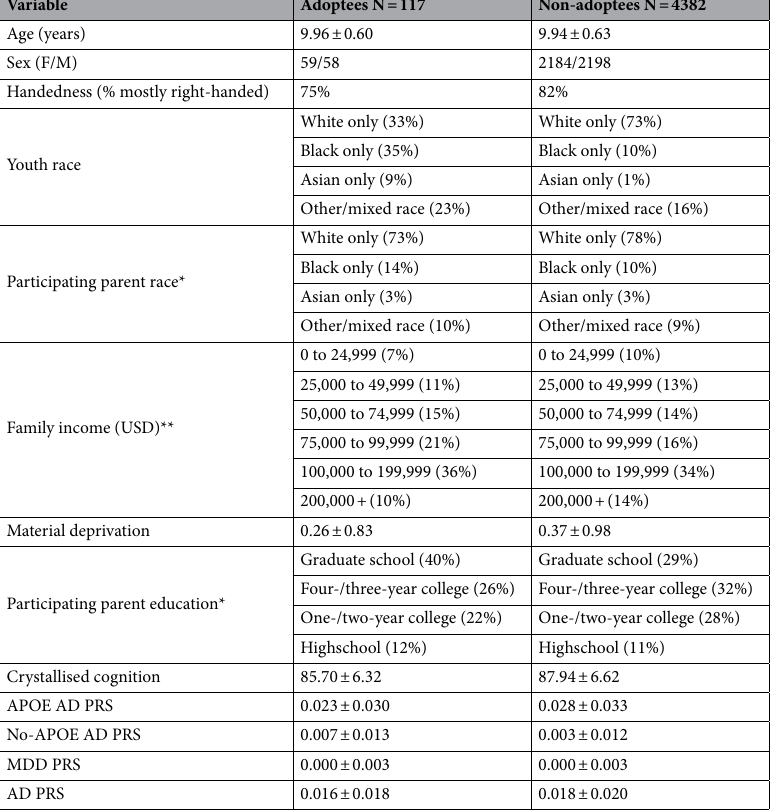
Table 1. Demographic and genetic risk information for adoptees and non-adoptees. GRS genetic risk score, AD Alzheimer’s Disease, MDD Major Depressive Disorder. *Due to data availability, we present racial and educational information for the participating parent who tended to be the mother in both adoptive and birth families (91% for both). **Only 103 adoptive families reported